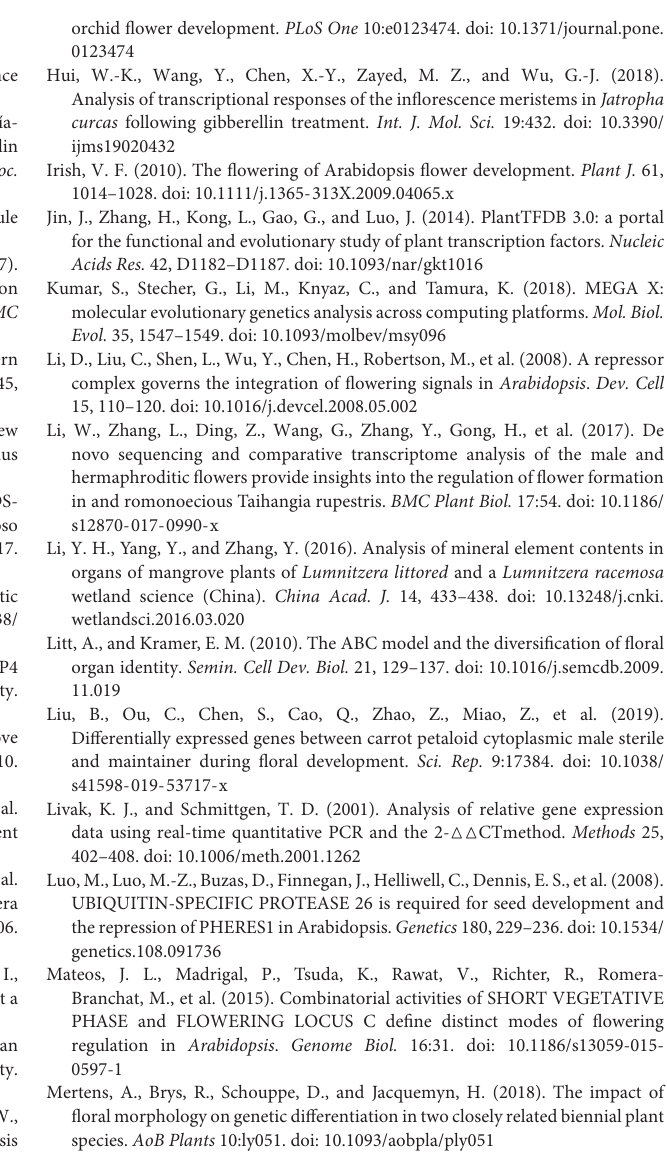
Supplementary Figure 3 | GO classification summarized by three main categories: Biological process, cellular component, and molecular function. Supplementary Figure 4 | COG and KOG functional classification of the unigenes of L. littorea with NR annotation.